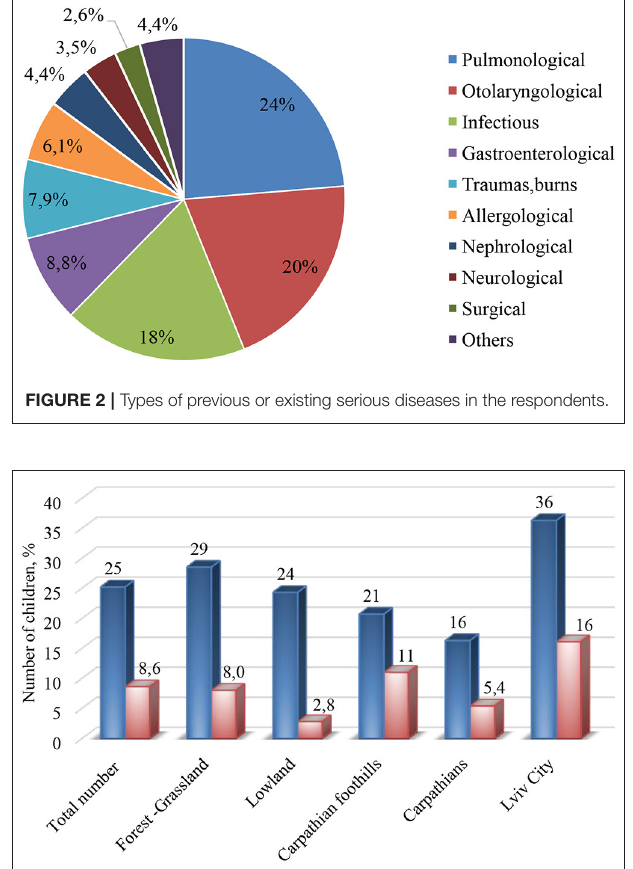
representing 20% ( n = 23) of serious diseases, which included otitis ( n = 15), tonsillitis ( 5), or other ( n = 3). Infectious diseases represented 18% ( n = 21) of all serious